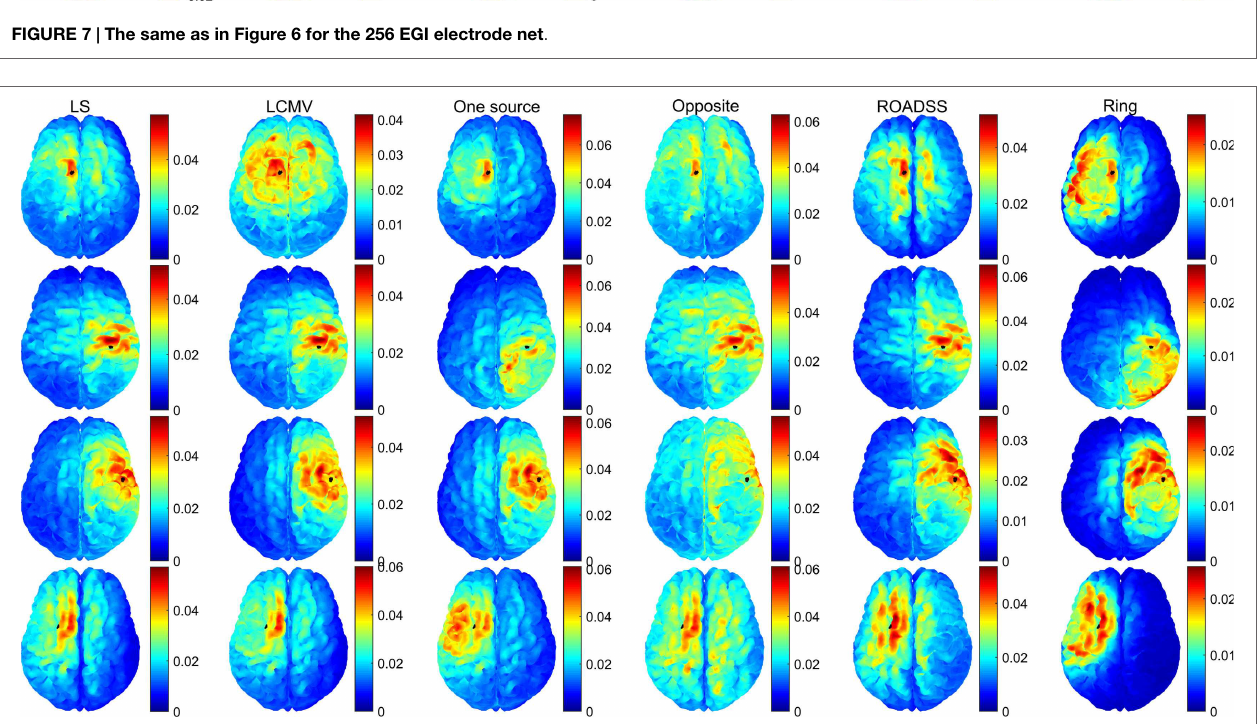
FIGURE 7 | The same as in Figure 6 for the 256 EGI electrode net .